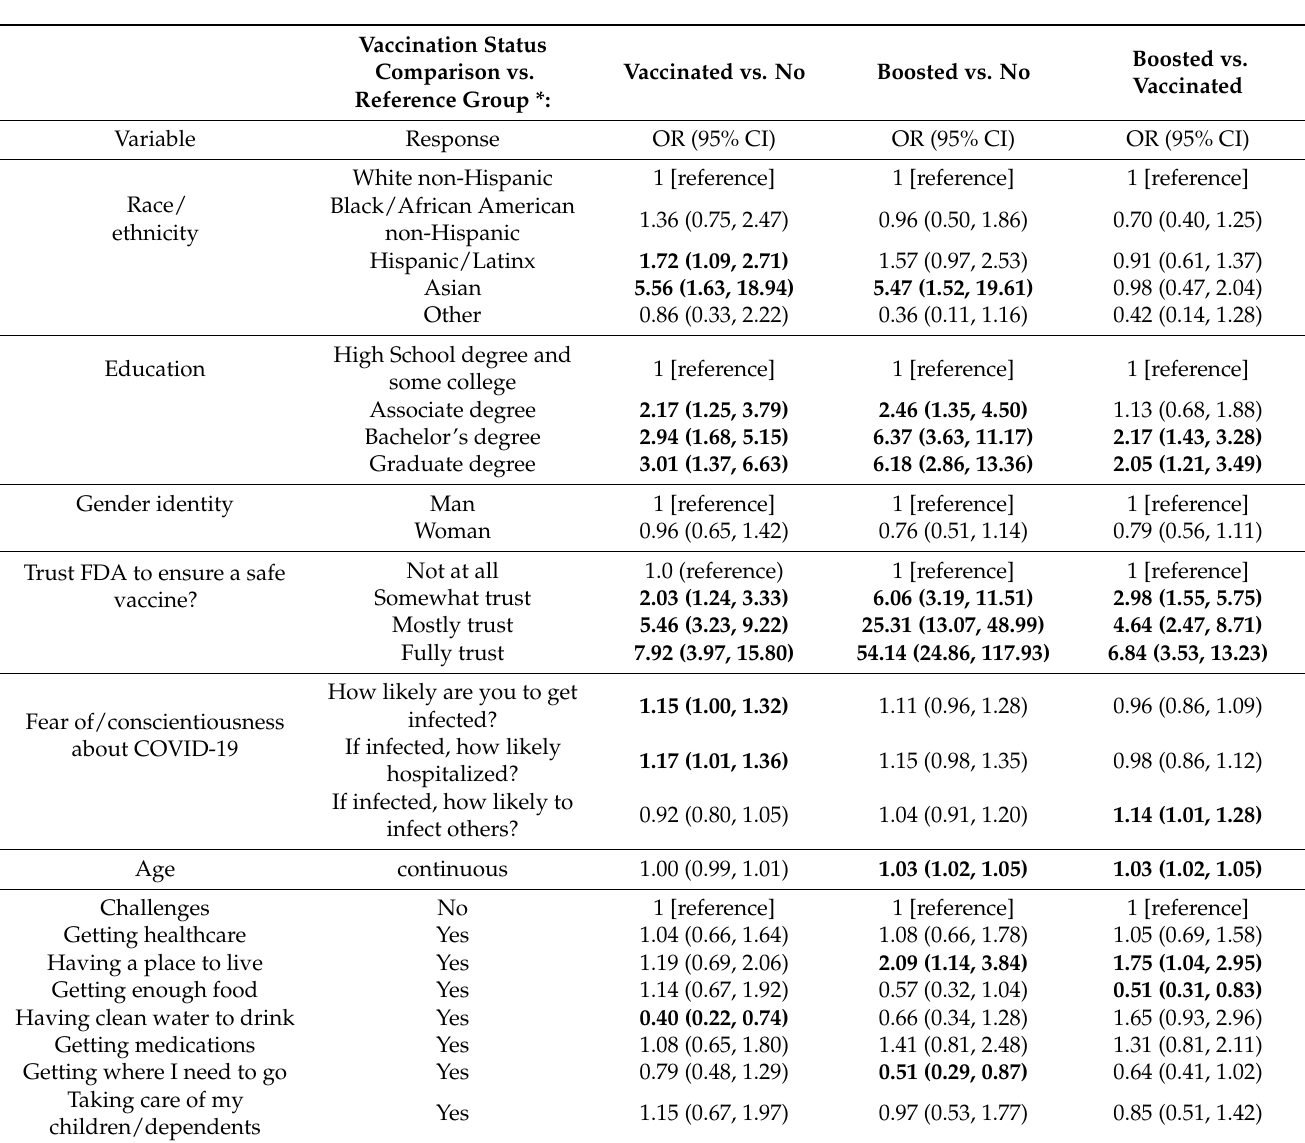
Table 2. Odds of COVID-19 vaccination status among a sample of adults in Texas, June–July 2022 ( n = 985).